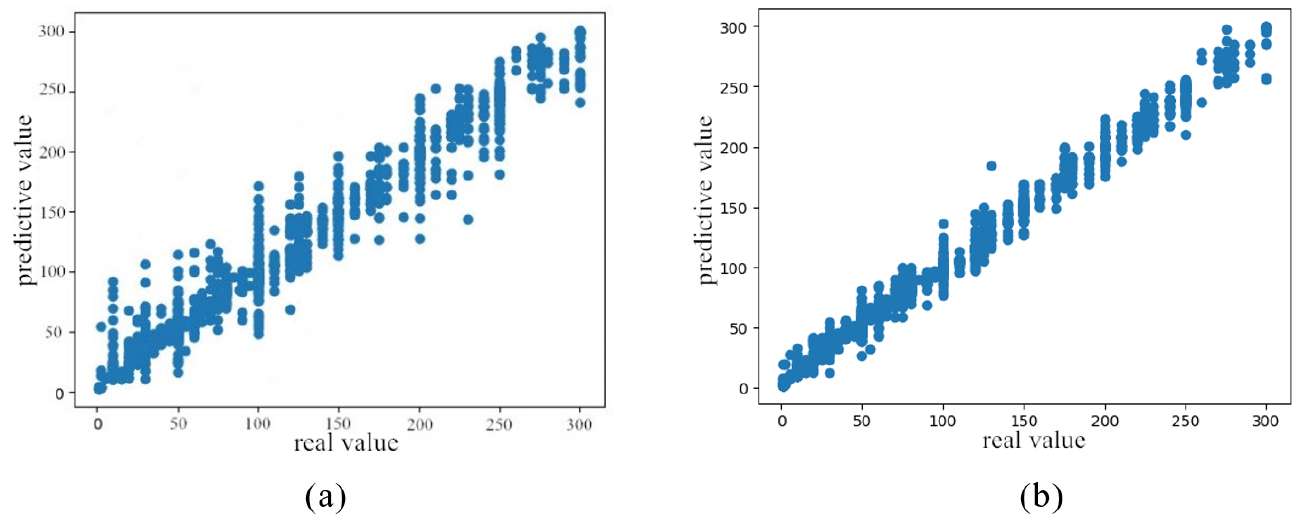
Figure 8. Comparison diagram of fitting algorithm. ( a ) Prediction result before stacking parameter optimization. ( b ) Predic- tion result after stacking parameter